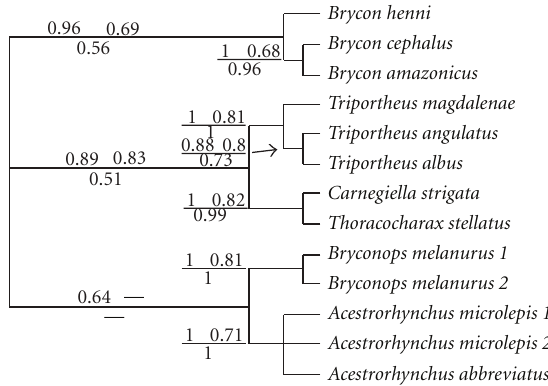
Figure 5: Relationships among the species of Triportheus and the family Gasteropelecidae. Numbers indicate posterior probability and bootstrap ( ≥ 0.50) values for 16S rDNA analyses (above line) and bootstrap value for combined data sets (below line) for each